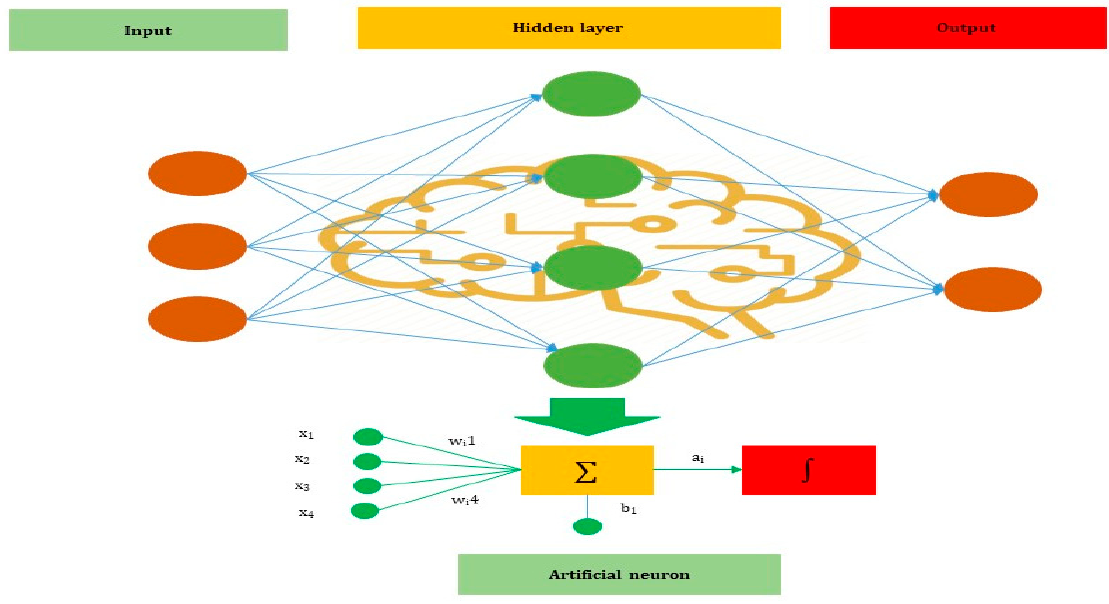
Figure 2. The basic structure of ANN.